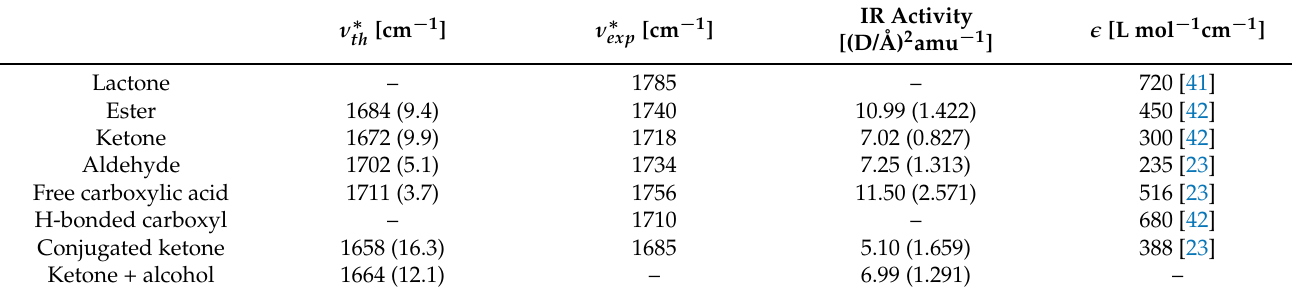
Table 5. Comparison of theoretical (average) frequencies and IR activities with the corresponding experimental values (frequencies and (cid:101) are extracted, for each species, from the references mentioned in Table 2). The calculated quantities are averaged over a number of insertion sites of the carbonyl in the lamellar model. The standard deviations of the frequencies and of the IR activities are given in